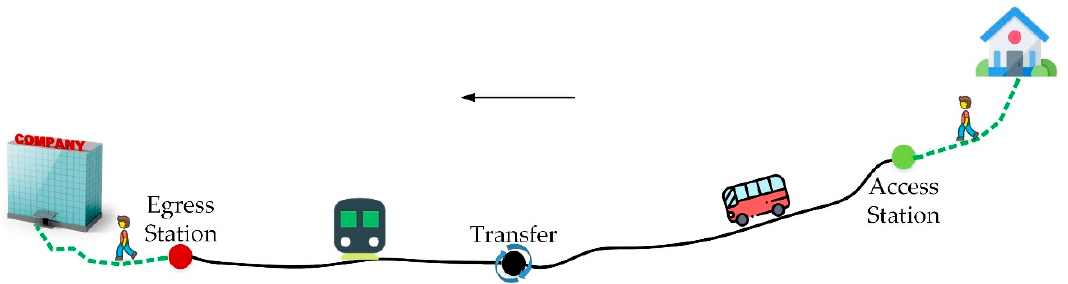
Figure 3. Sketch diagram of traveling by public transport.